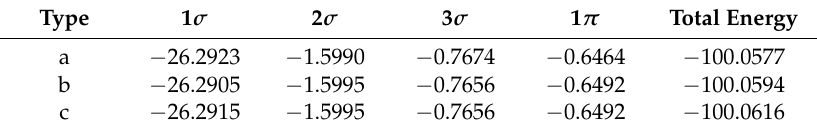
Table 1. One-electron MO energy and the total energy of the HF molecule (in atomic units).